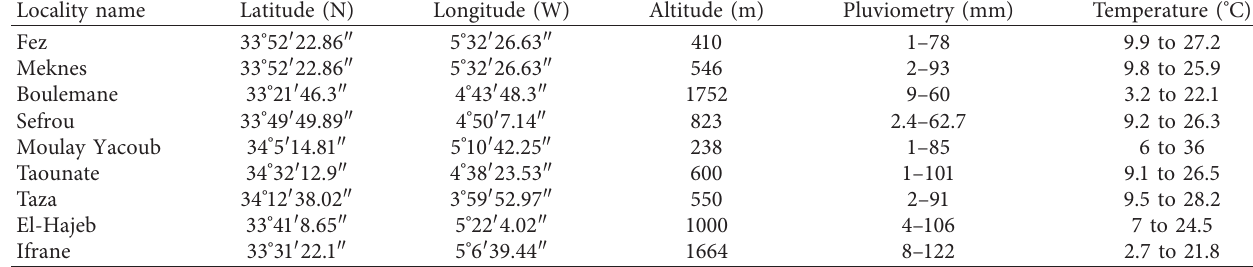
Table 1: Climatic and geographical information of the Fez-Meknes region.